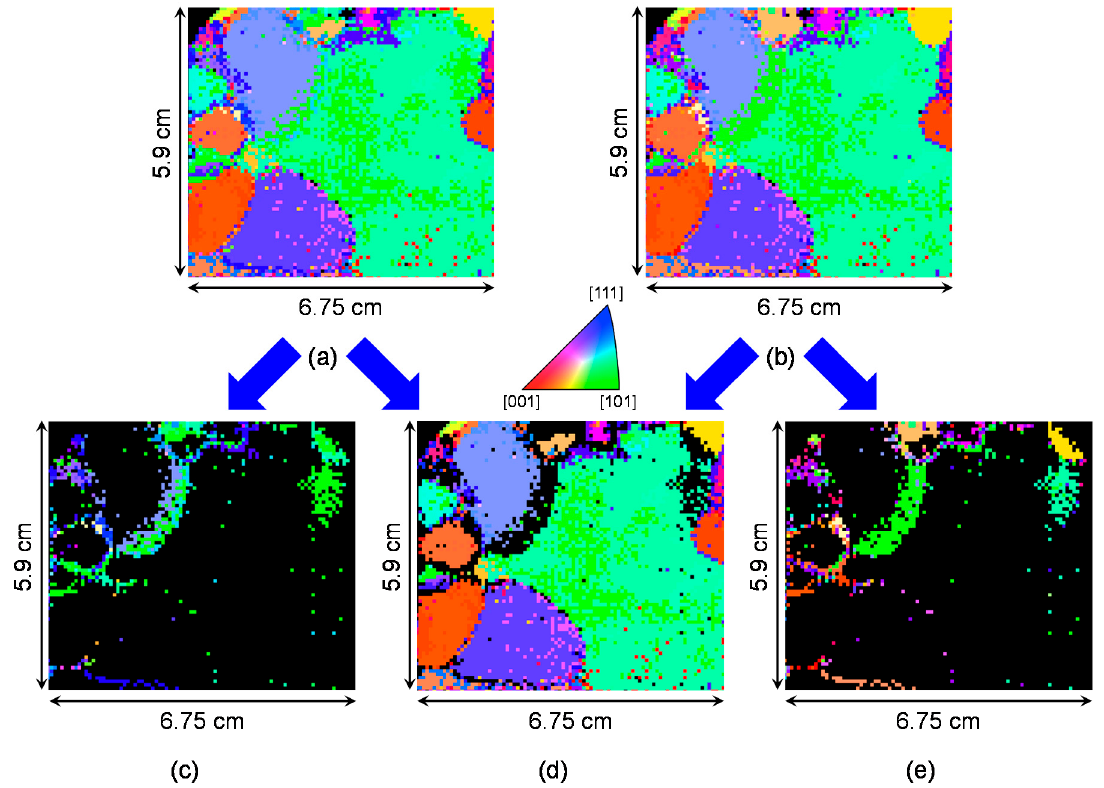
Figure 20. Grain orientation images obtained by Bragg-dip neutron transmission analyses, expressed by inverse pole figure (IPF). ( a ) and ( b ) are images of all grains. ( c )–( e ) are partial images of the images ( a ) and ( b ). The image ( d ) indicates IPF map of a non-stacked grain along the neutron transmission path. The image ( c ) indicates IPF map of one of stacked grains along the neutron transmission path and the image ( e ) indicates IPF map of the other of stacked grains along the neutron transmission path. The image ( a ) is a combined image of the image ( d ) and the image ( c ) and the image ( b ) is a combined image of the image ( d ) and the image ( e ). These figures are reproduced with permission of the International Union of Crystallography from Reference [28].